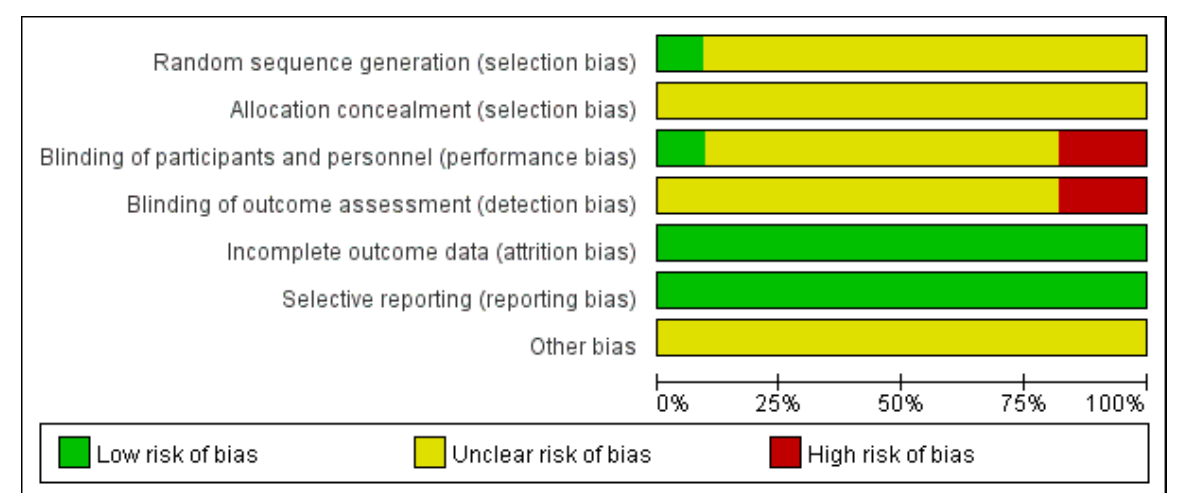
Figure 2. Review authors’ judgements about each risk of bias item presented as percentages across all RCT studies. Table 3. Methodological Index for Non-randomized Studies (MINORS) scores for the included studies